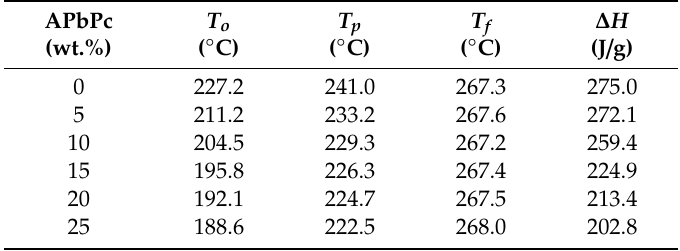
Figure 2. Di ff erential scanning calorimetry (DSC) curves of P-ddm / APbPc blends at di ff erent wt.% of APbPc. Table 1. DSC data for P-ddm / APbPc blends at di ff erent wt.% of